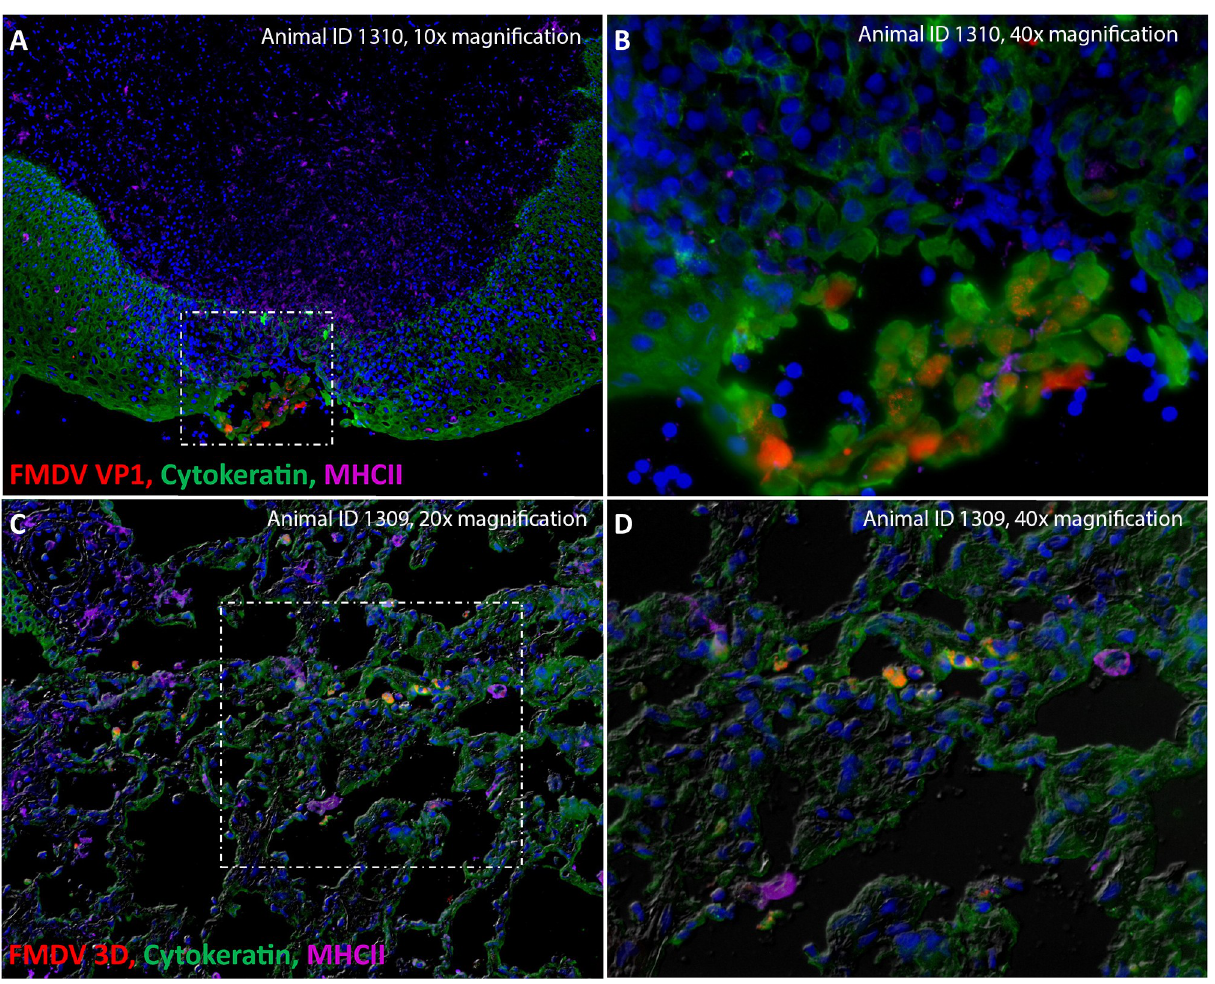
Fig 3. FMDV infection in ovine nasopharyngeal mucosa and lungs during early stages of disease in aerosol-inoculated sheep. A-B) FMDV infection in the dorsal nasopharyngeal mucosa at 24 hours post aerosol inoculation (animal ID 1310). FMDV VP1 (red) is localized to cytokeratin+ epithelial cells (green) within a surface erosion in a segment of MALT-associated epithelium. MHCII+ cells are abundant throughout the submucosa and are infiltrating the area of the lesion. A = 10x magnification. B = 40x magnification. C-D) Microscopic distribution of FMDV non-structural protein 3D (red) in lungs of FMDV-infected sheep at 24 hours post aerosol inoculation (animal ID 1309). FMDV 3D (red) predominantly localizes within intact and acantholytic cytokeratin-positive pulmonary epithelial cells (green), but not with MHC II (purple) expressing host cells. C = 20x magnification. D = 40x magnification with differential interference